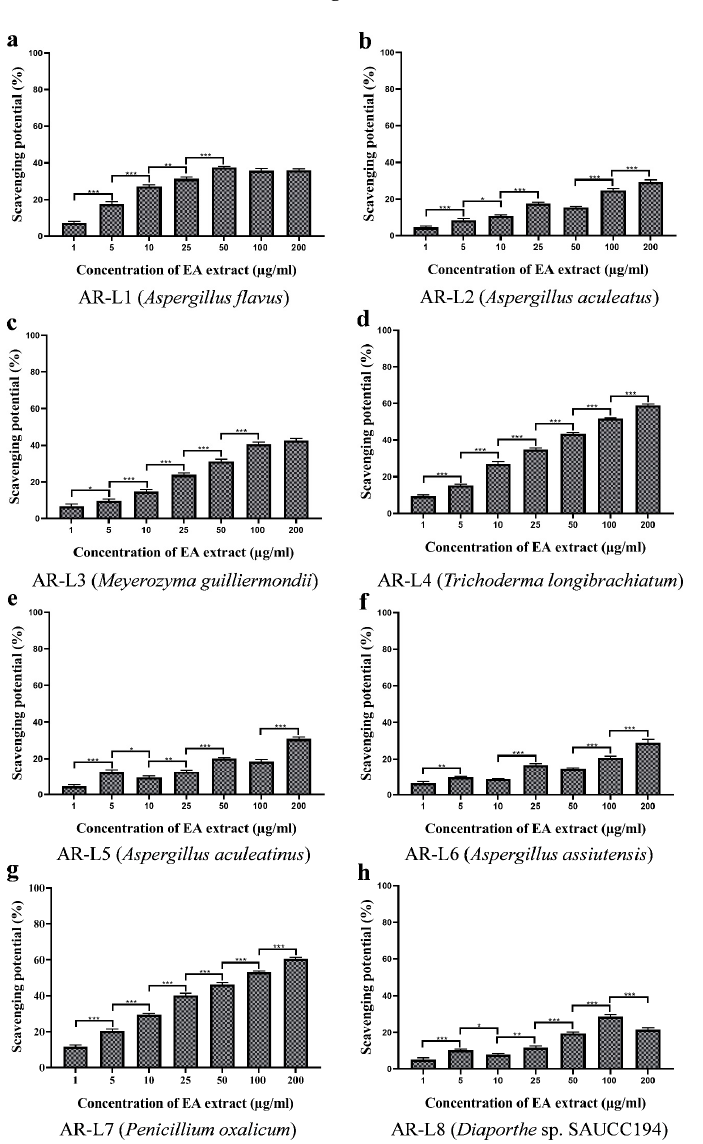
Figure 6. Nitric oxide scavenging potential of EA extract of fungal endophytes ( a ) A. flavus , ( b ) A. aculeatus , ( c ) M. guilliermondii , ( d ) T. longibrachiatum , ( e ) A. aculeatinus , ( f ) A. assiutensis , ( g ) P. oxalicum and ( h ) Diaporthe sp. SAUCC194. All the experiments were performed in triplicate. p -value was calculated by comparing means ± SD of the nitric oxide radical scavenging potential (%), using one-way ANOVA followed by Tukey to determine statistical significance, which are as follows; *** p ≤ 0.001; ** p ≤ 0.002; * p ≤ 0.033.